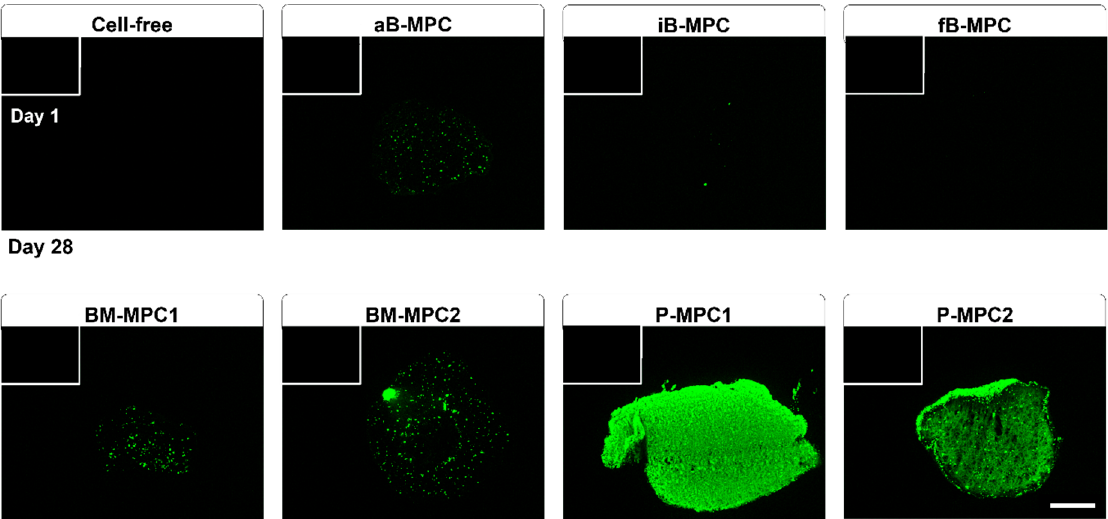
Figure 4. Mineralization of printed constructs. Histological staining on day 1 (white bordered rectangle) and day 28, using OsteoImage™ Mineralization Assay. Scale bar = 500 µm.